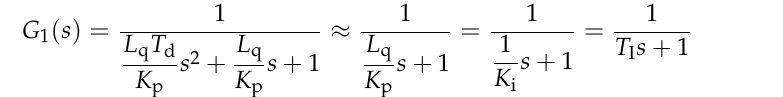
Figure 9. Servo motor dynamic block diagram.